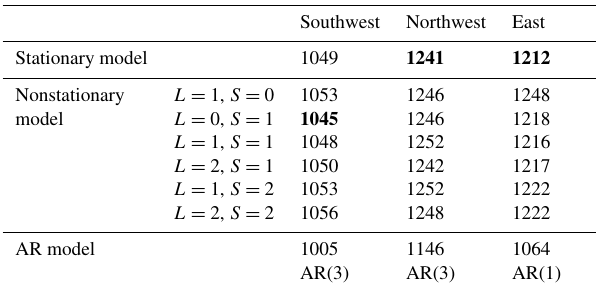
Table 3. BIC values for stationary and nonstationary GEV models fitted to the tree-ring-reconstructed PDSI